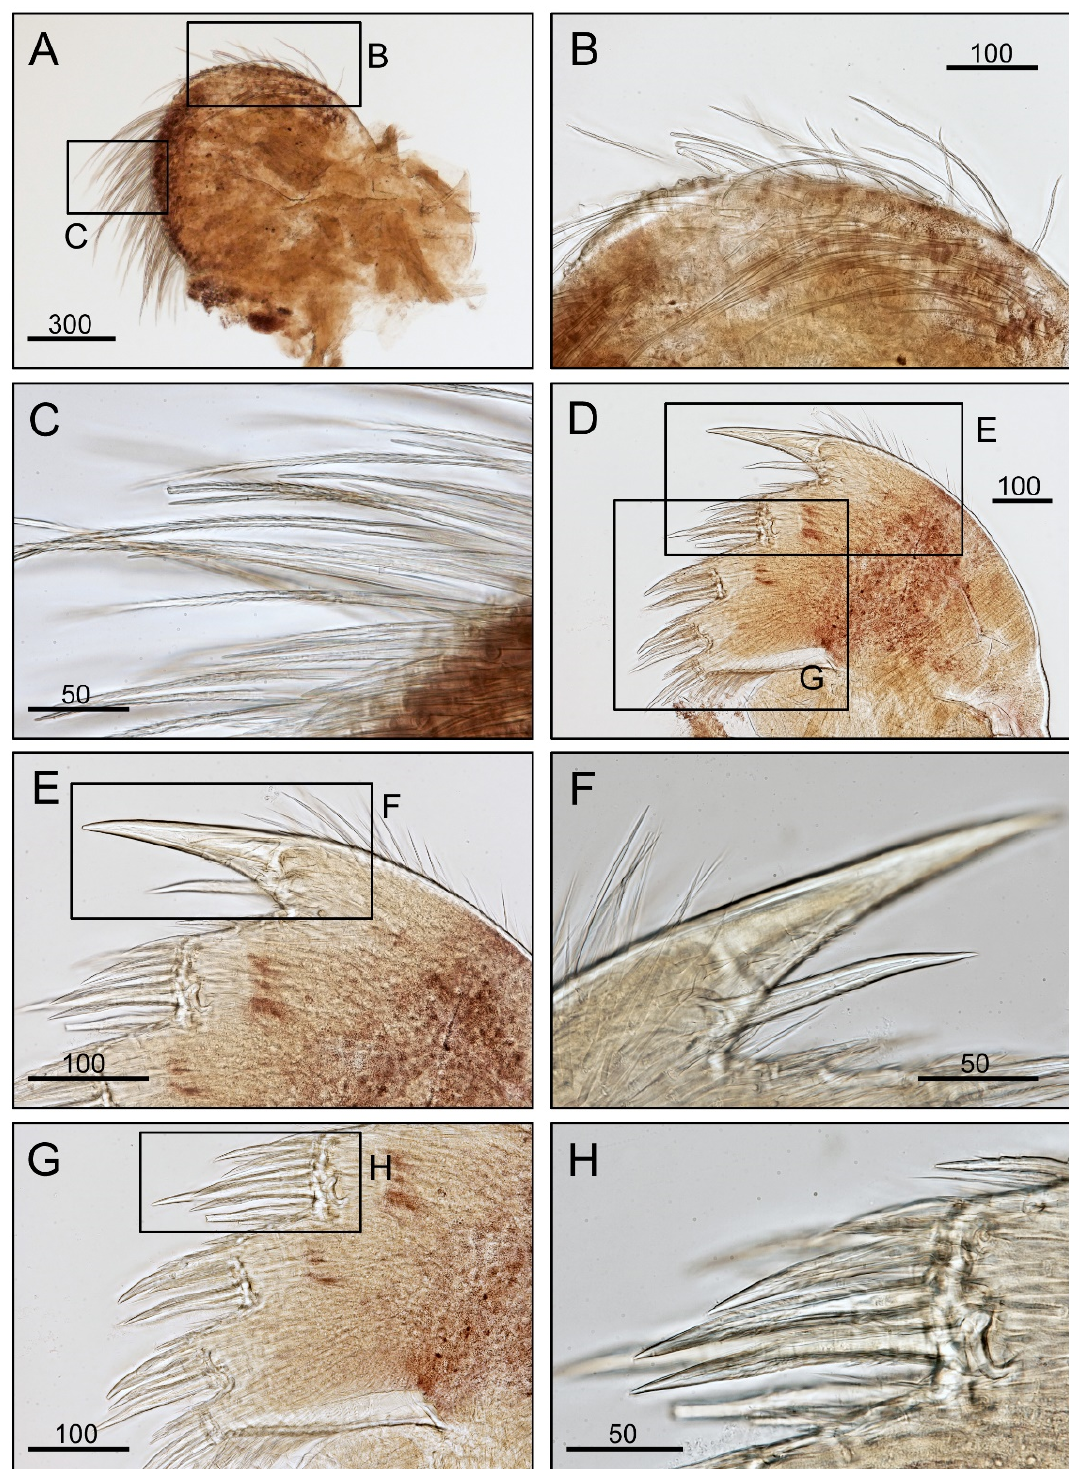
Figure 5. Conchoderma virgatum . ( A ) Maxilla. ( B ) Simple setae at outer margin of maxilla. ( C ) Serrulate setae at inner margin of maxilla. ( D ) Maxillule showing three zig-zag regions at the cutting edge. ( E ) Large spine of maxillule. ( F ) Simple setae at the base of large spine of maxillule. ( G ) Cutting edge of maxillule. ( H ) Serrulate-type setae at the cutting edge of maxillule. Scale bars in μ m.